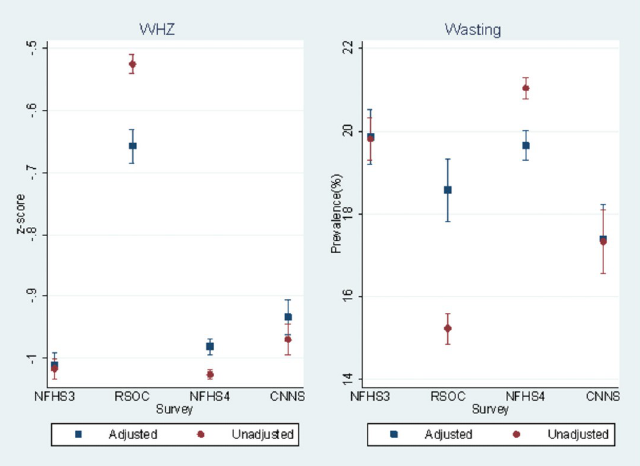
Fig 4. Estimated mean WHZ and prevalence of wasting by month of survey from pooled data of four surveys with adjusted and unadjusted estimates.